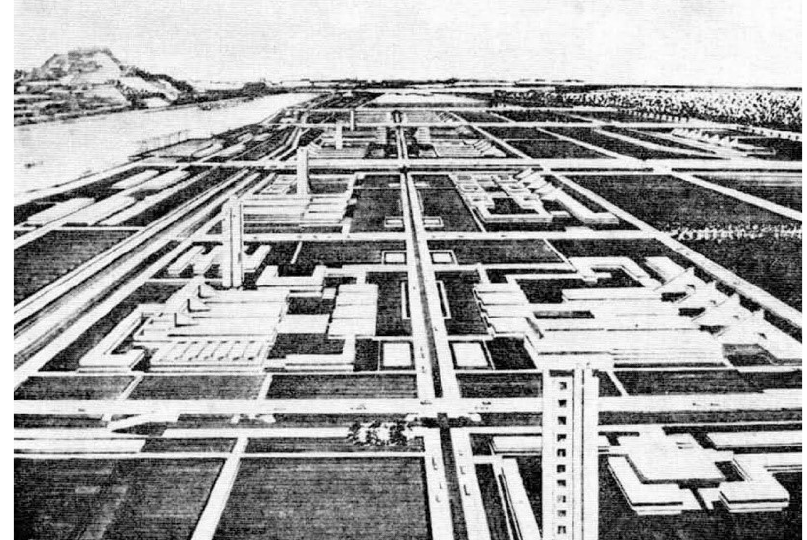
Figure 3. Informative perspective of the industrial zone on the left bank of the Danube from the study “Development of the Belgrade economy and the possibilities of its inclusion in the world market” drafted by Belgrade Chamber of Commerce, Secretariat for Economy and Faculty of Economics in Belgrade in 1970. Source: [44]